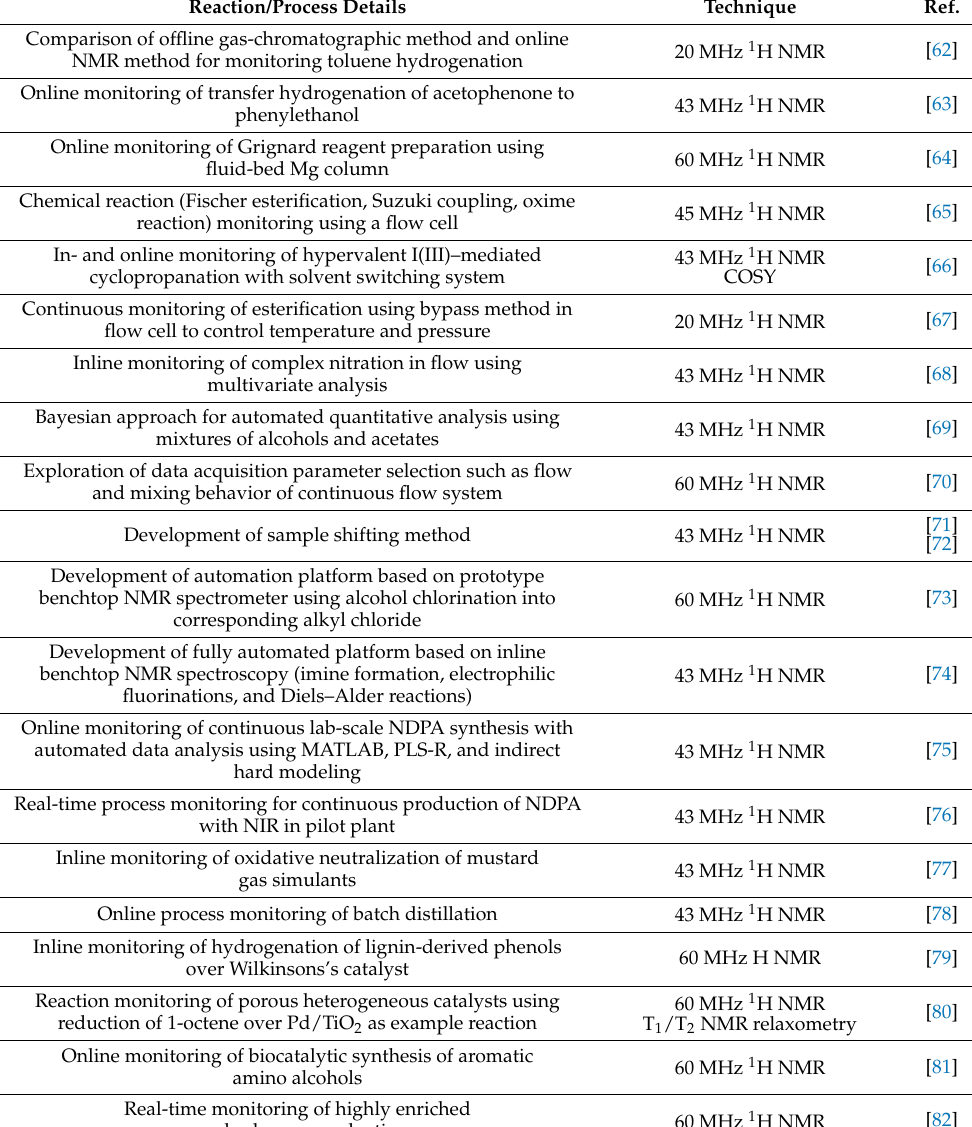
Table 4. Applications of benchtop NMR spectroscopy for process and reaction monitoring. Reaction/Process